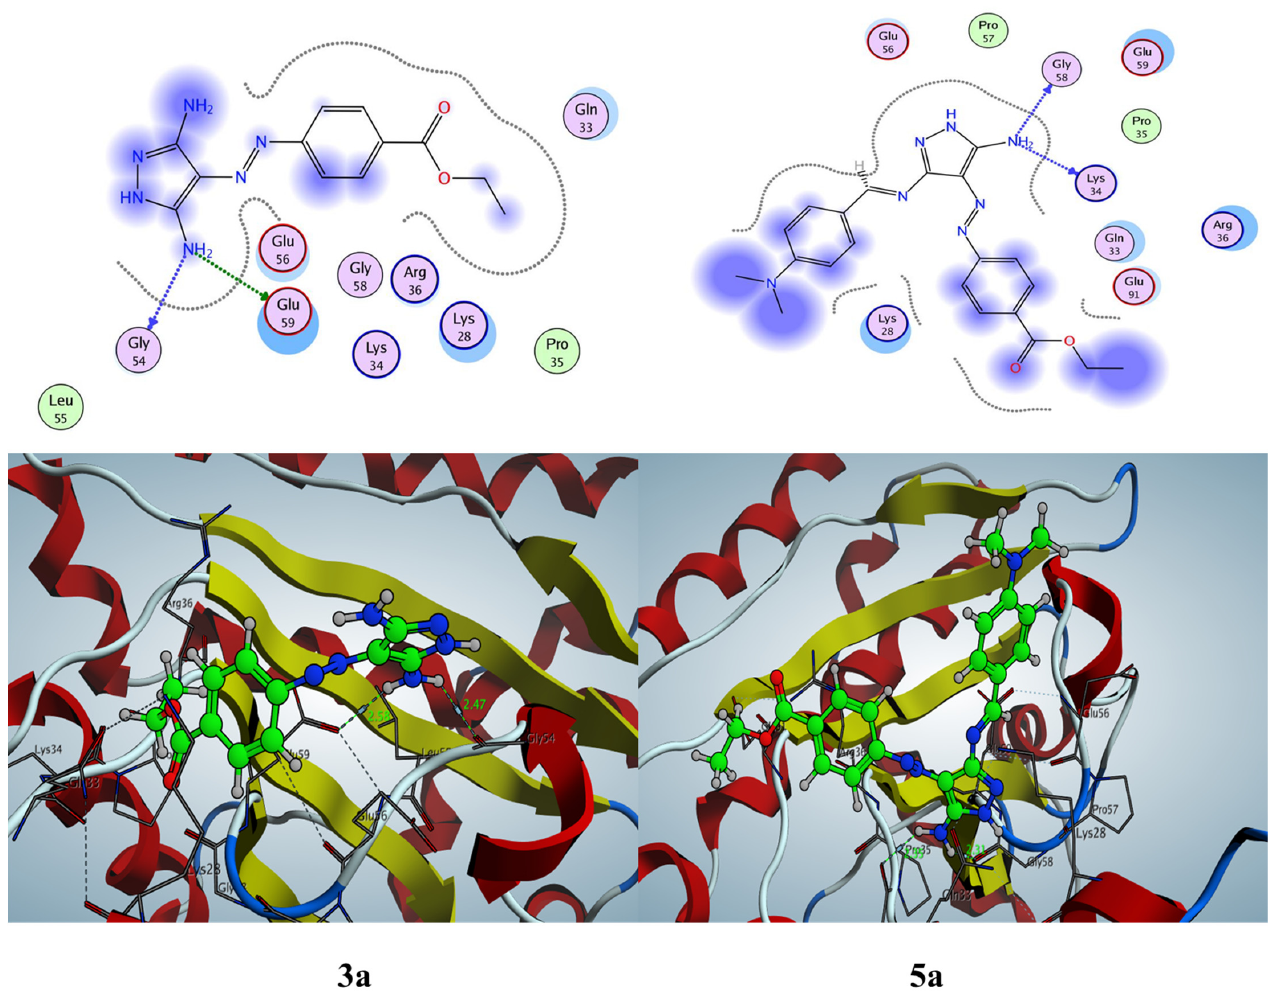
Figure 15. 2D and 3D enzyme–ligand interaction of compounds 3a and 5a inside the active site of beta CA (PDB: 1I6P) .